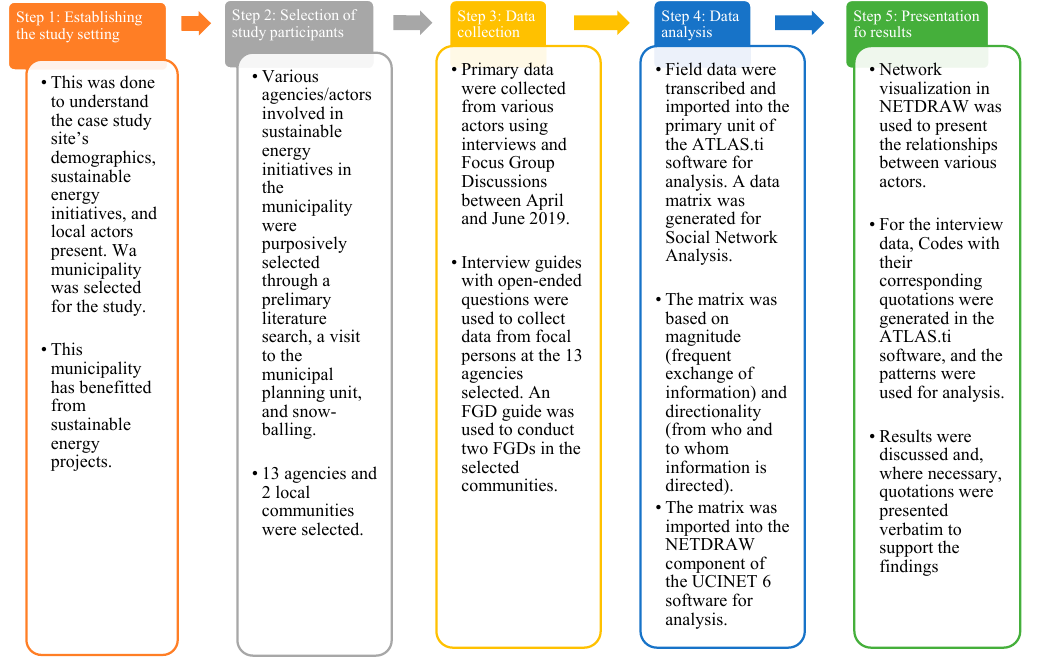
Figure 1. The major methodological steps (Source: Authors’ conception).